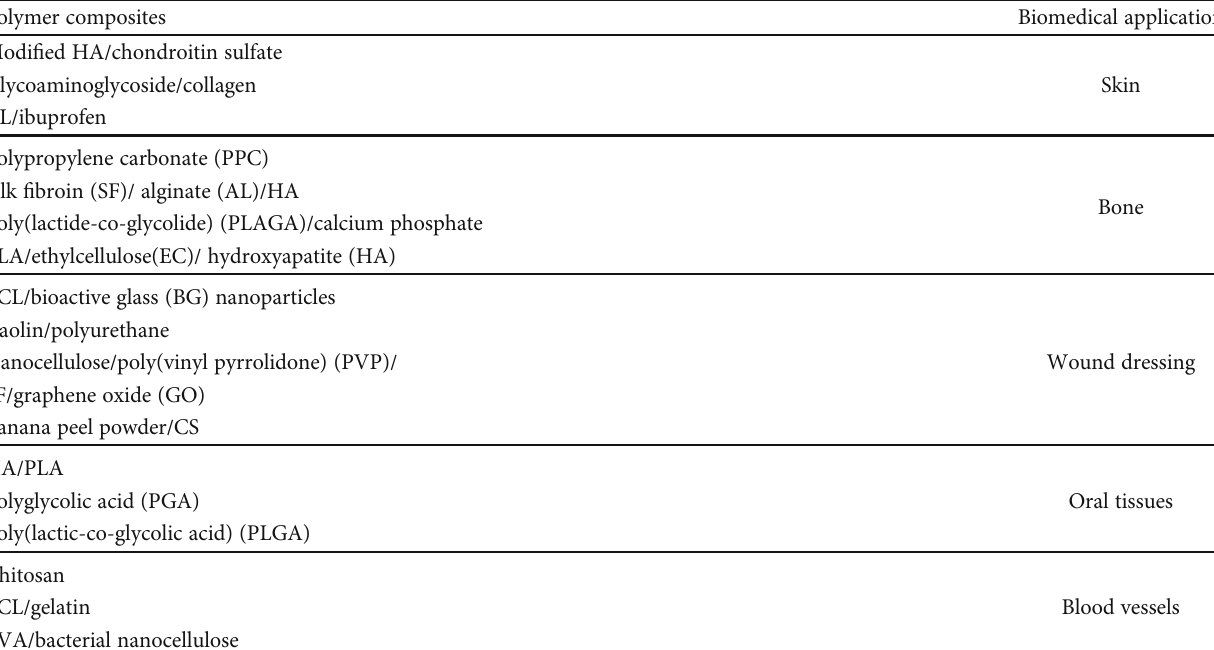
Figure 3: Images of surgical operation. (a) The central region of the tibia was removed using an oscillating bone saw (black arrow). (b) The HA/PDLLA composite was inserted into the space created (white arrow). (c) The b-TCP composite was inserted into the space created (black arrow) [52]. Table 2: Polymer composites for biomedical applications